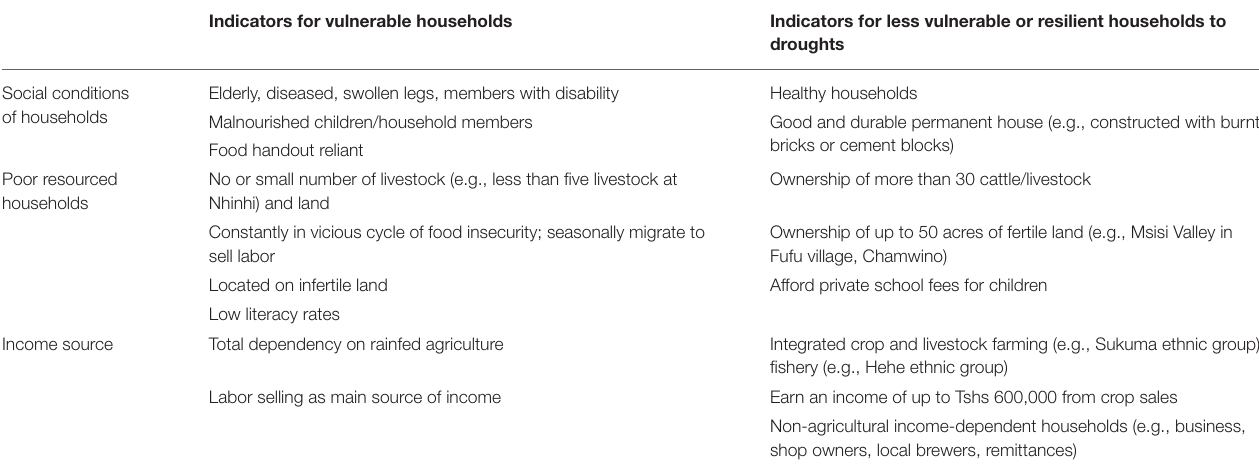
TABLE 4 | Drivers of the vulnerability of households to drought-induced food insecurity. Indicators for vulnerable households Indicators for less vulnerable or resilient households to